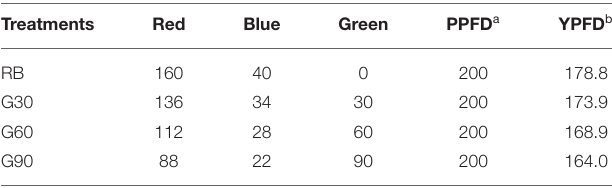
Frontiers in Plant Science |